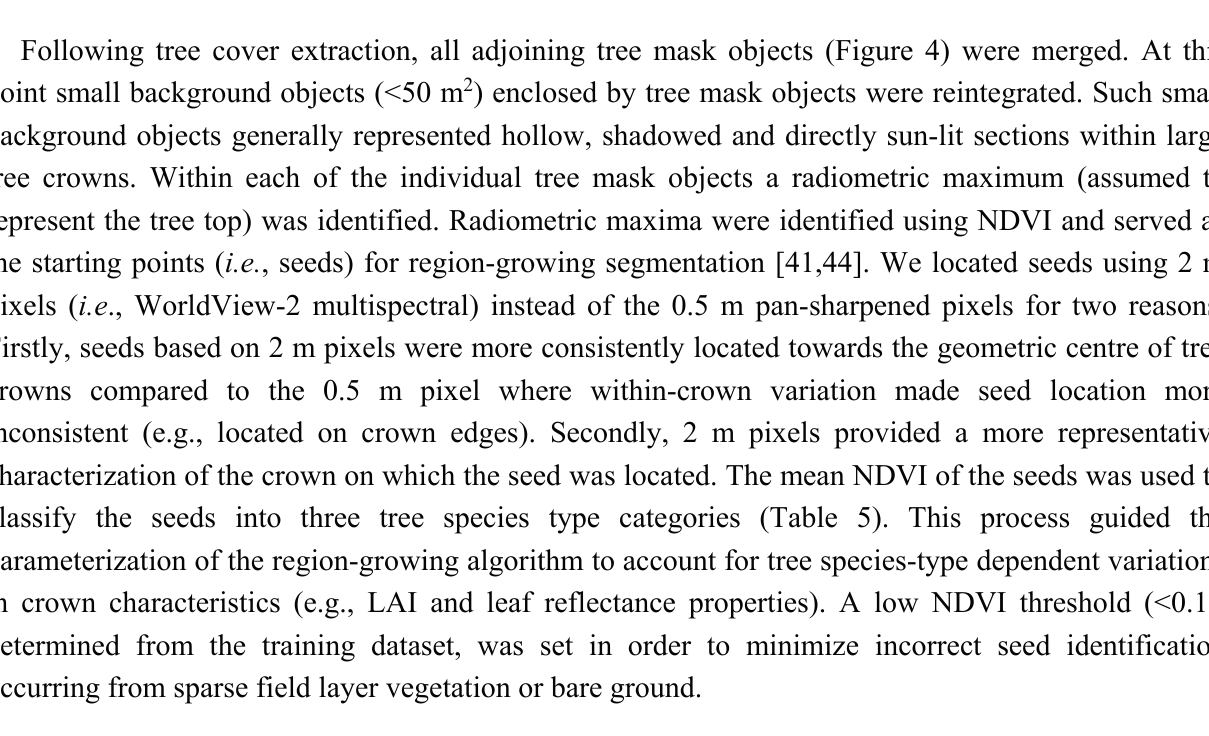
Figure 4. ( a ) True color WorldView-2 image of active fields (bright background) and fallows (dark background); ( b ) tree cover mask and non-tree cover areas